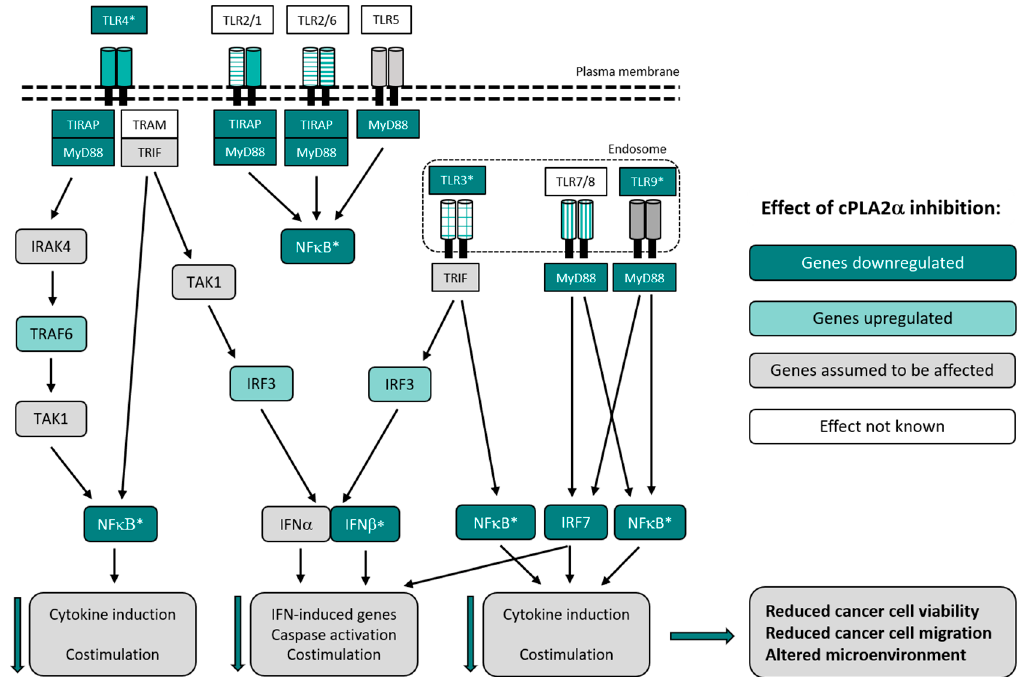
Figure 4. Hypothesized e ff ects of CIX in TLR signaling in 4T1 cells. By reduced signaling through TLR3, TLR4, TLR9, and NF- κ B (rel), it is likely that cPLA2 α inhibition a ff ects the cancer microenvironment and reduces both cancer cell viability and migration, and the level of inflammation. Such an altered cancer cell microenvironment may suggest that cPLA2 α regulates many aspects of cancer cell biology and thus serves as an attractive target for metastatic cancer. The figure is modified after [47,54]. Dark green nodes represent genes found to be downregulated, light green nodes represent upregulated genes. Grey and white nodes represent genes assumed to be a ff ected or without known e ff ects, respectively. Downward pointing green arrows indicate that these processes are down-regulated by CIX. *Regulation of gene expression confirmed by RT-qPCR (Figure A1, Appendix B).